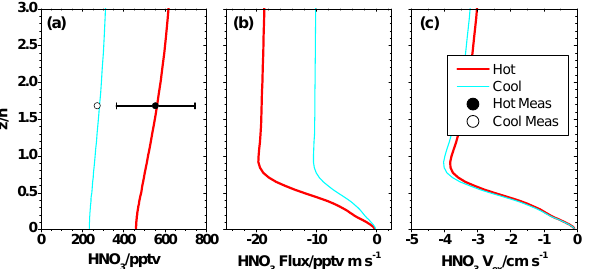
Fig. 11. Vertical profiles of (a) mixing ratios, (b) fluxes and (c) exchange velocities for HNO 3 . Model results are shown for both hot and cool periods. Filled and open circles represent observations (mean ± 1 σ ) for the hot and cool periods, respectively. The stan- dard deviation for observed HNO 3 mixing ratios in the cool period is ± 4pptv.